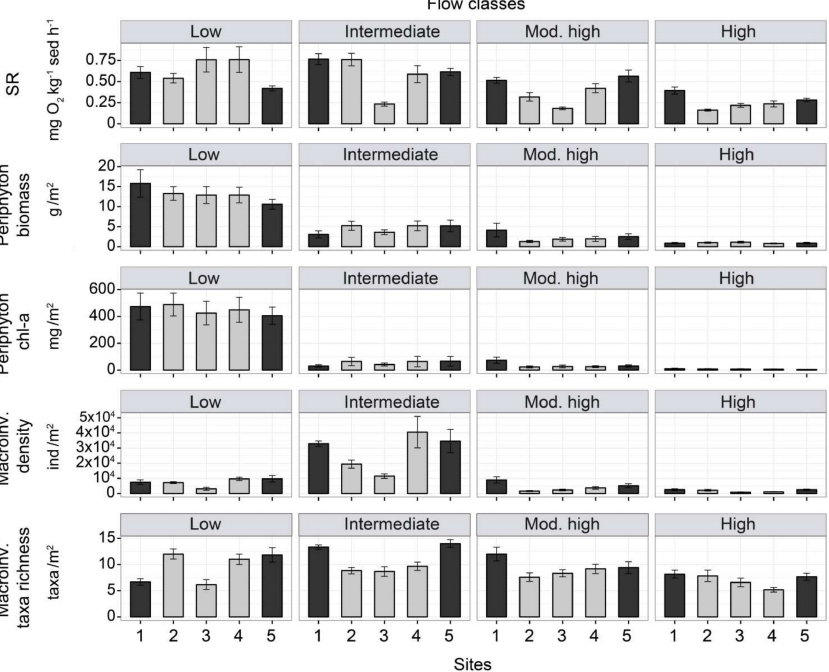
Figure 3. Ecosystem structure and function measures by site and flow class (average ± standard error). Black bars (Sites 1 and 5) represent non-restored sites, while grey bars (Sites 2–4) represent restored sites. SR = sediment respiration; Macroinv = macroinvertebrate; Mod. High = moderately